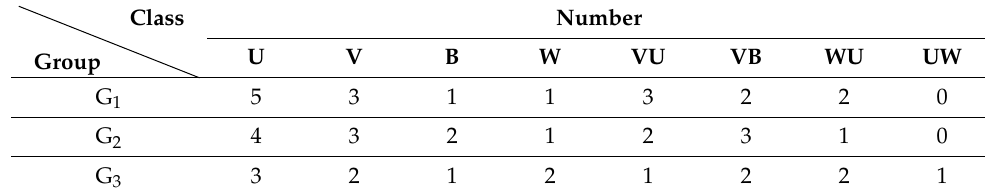
Table 5. The accuracy statistics for real data 1.